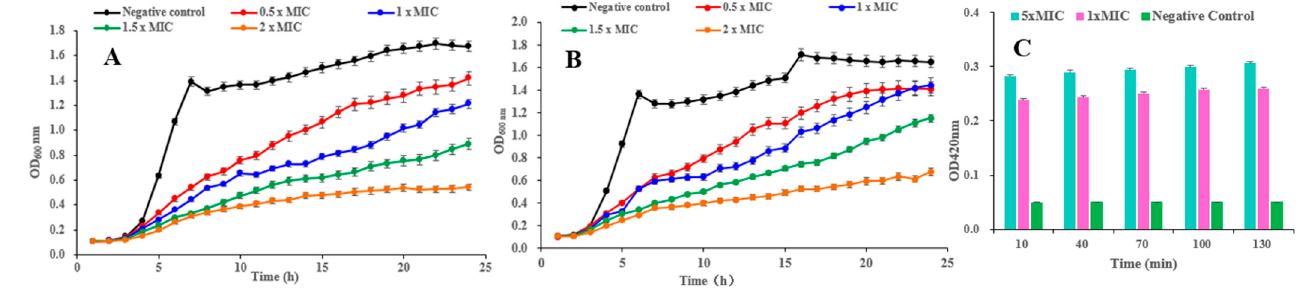
Figure 5. ( A , B ) Effects of compound 1 on the growth curves of B. cereus and S. aureus , respectively; ( C ) effect of 1 on the cell membrane permeability of B. cereus .